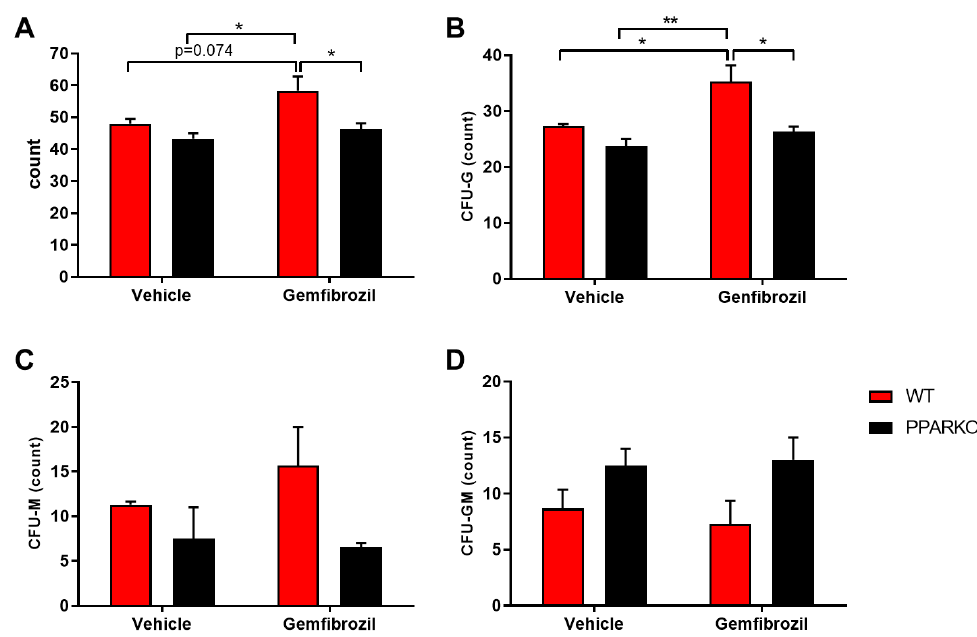
Figure 5. Gemfibrozil treatment increased total colony-forming units in the bone marrow. Gemfibrozil treatment tended to increase total CFU count; ( A ) CFU-granulocyte also increased after gemfibrozil treatment; ( B ) No statically significant di ff erences were found in CFU-M ( C ) nor CFU-GM; ( D ) Moreover, PPAR-alpha deletion blunted these e ff ects of gemfibrozil. Data are presented as mean ± SEM; n = 4–5 per group. Two-way ANOVA followed by Tukey’s post hoc test. * p < 0.05; ** p < 0.01.